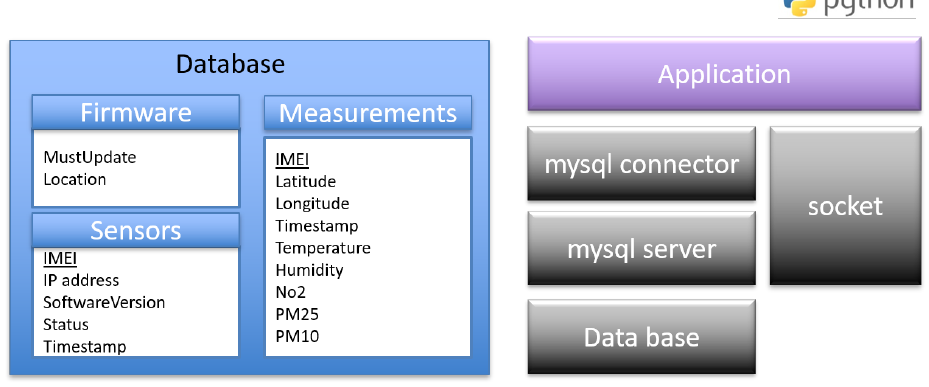
Figure 10. Server software